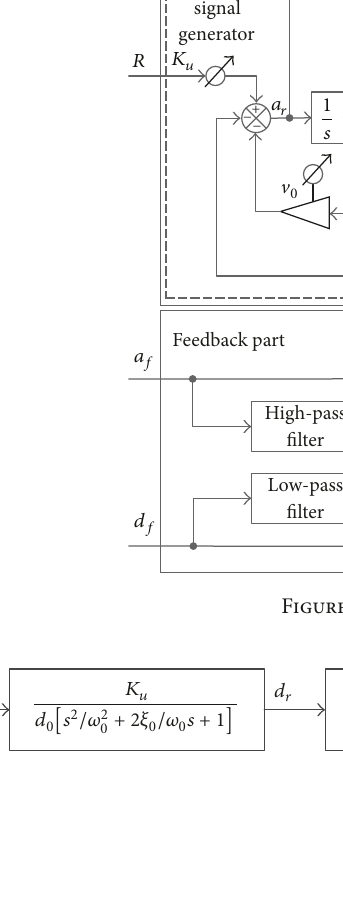
Figure 3: Block diagram of the control